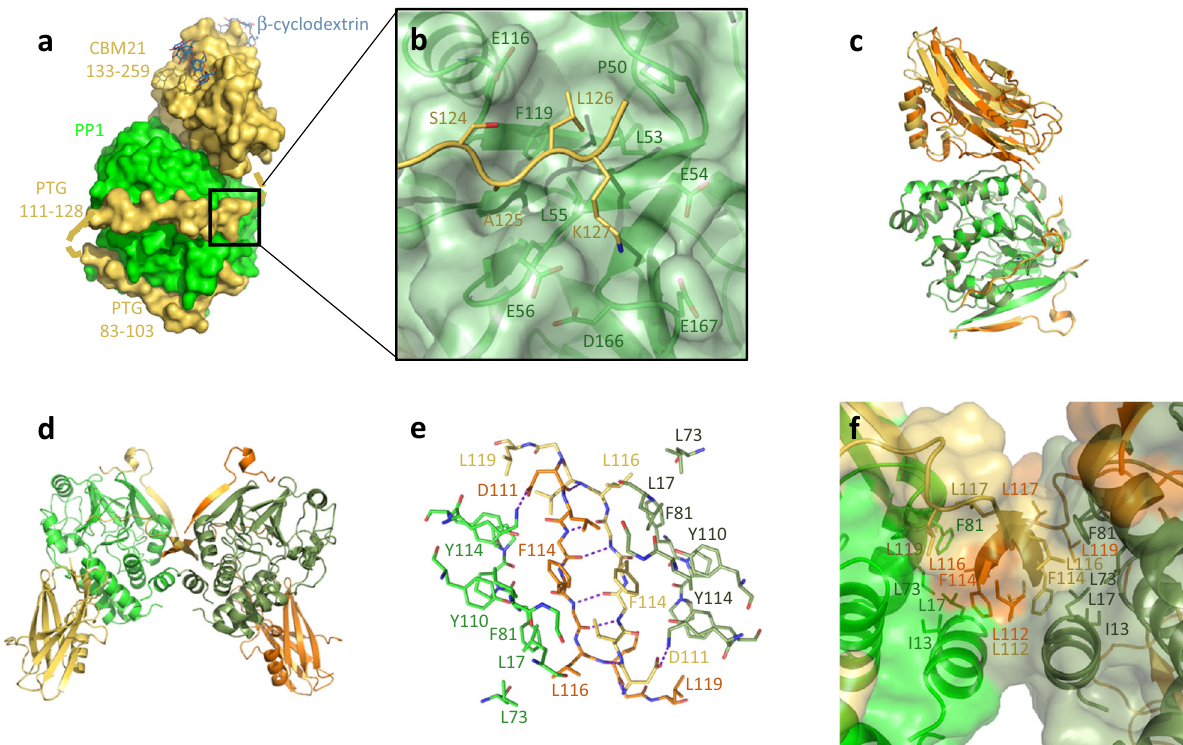
Fig. 3 | Structural organization of the ternary PP1/PTG/cyclodextrin complex. a The PTG (yellow) region (aa. 111 – 128) crosses the PP1 surface (green) to connect its N-terminal stretch to the CBM21 on the opposite PP1 side. b The PTG residues 124 SALK 127 fi llasmallgrooveonthePP1surface. c Superpositionofthetwodimersin